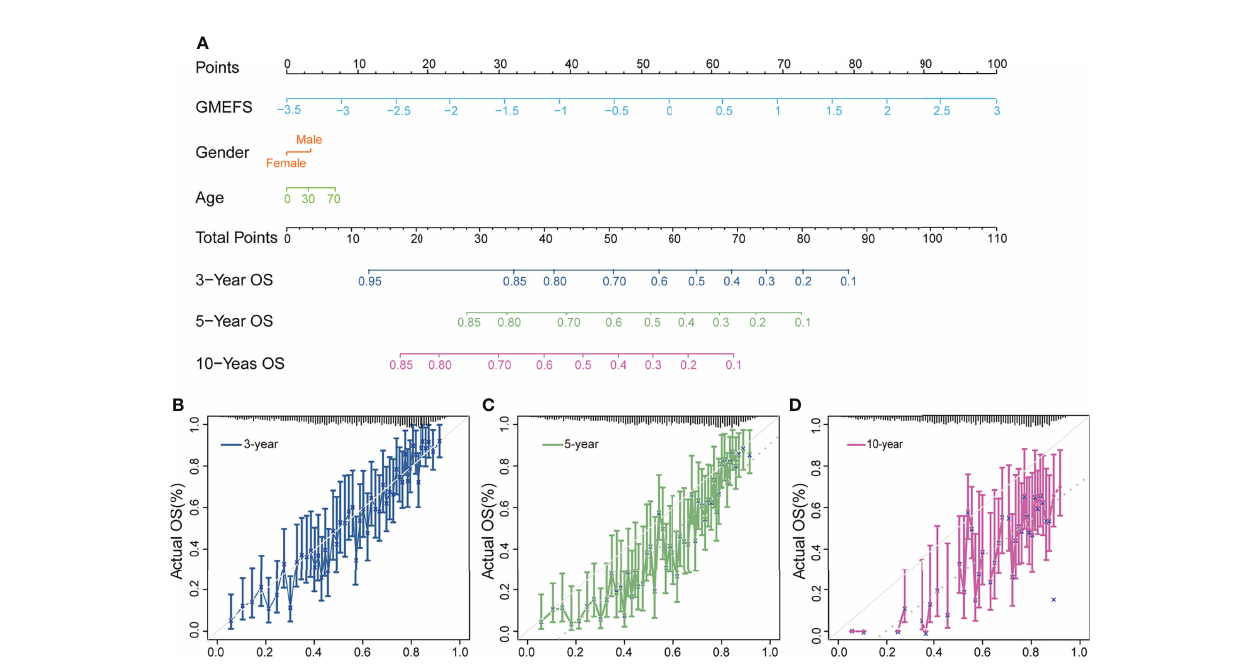
FIGURE 2 | Nomogram developed for predicting the probability of 3-, 5-, and 10-year overall survival in the training cohort. (A) The nomogram was constructed in the training cohort, with the GMEFS and available clinical factors incorporated. Calibration plot of the nomogram in terms of agreement between the predicted and observed (B) 3-, (C) 5-, and (D) 10-year